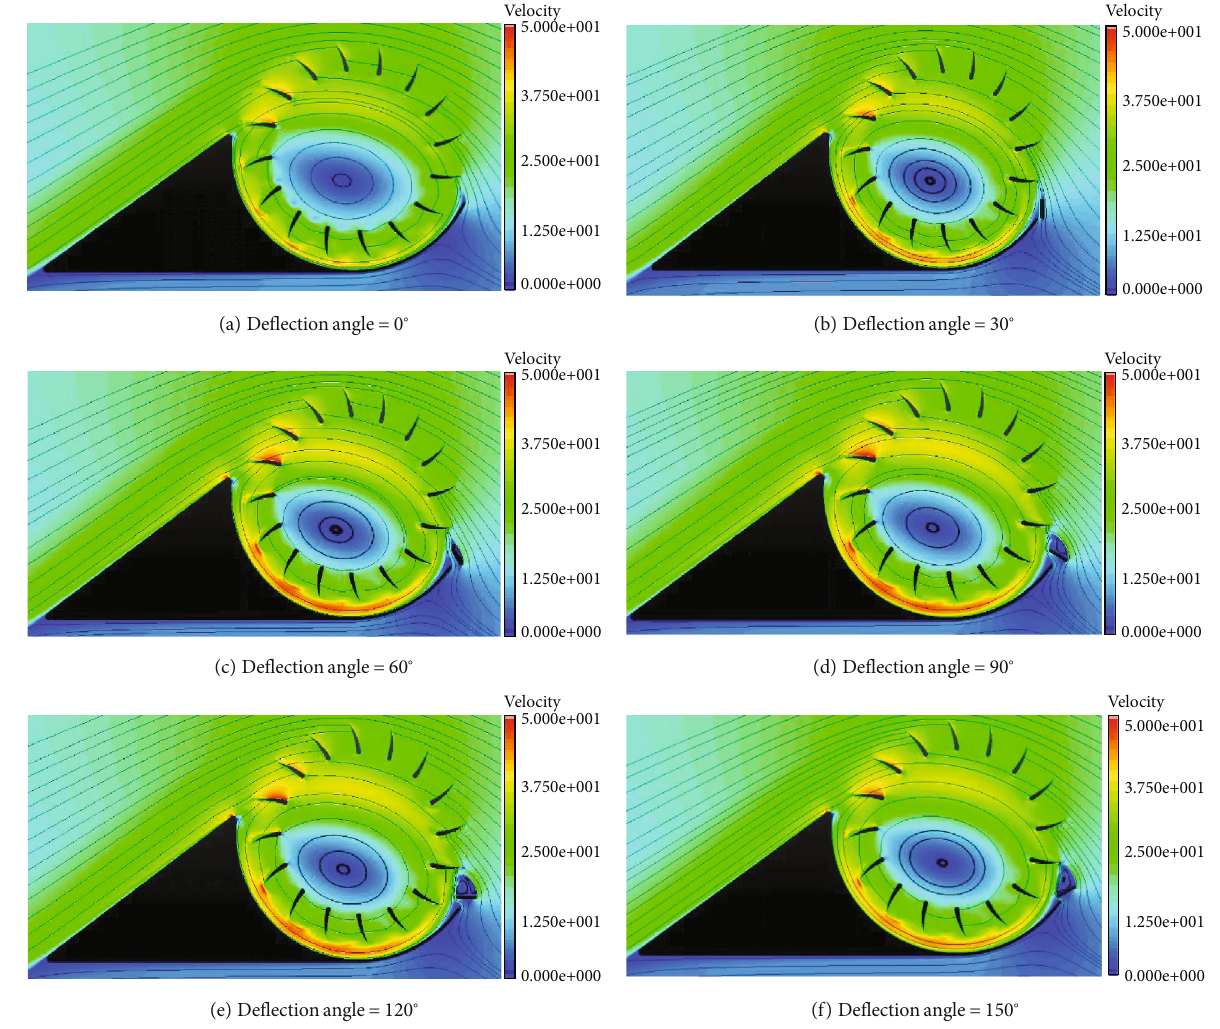
Figure 8: Velocity nephogram and streamline diagram of a single leading edge winglet ( v = 12 m/s, α = 0 °